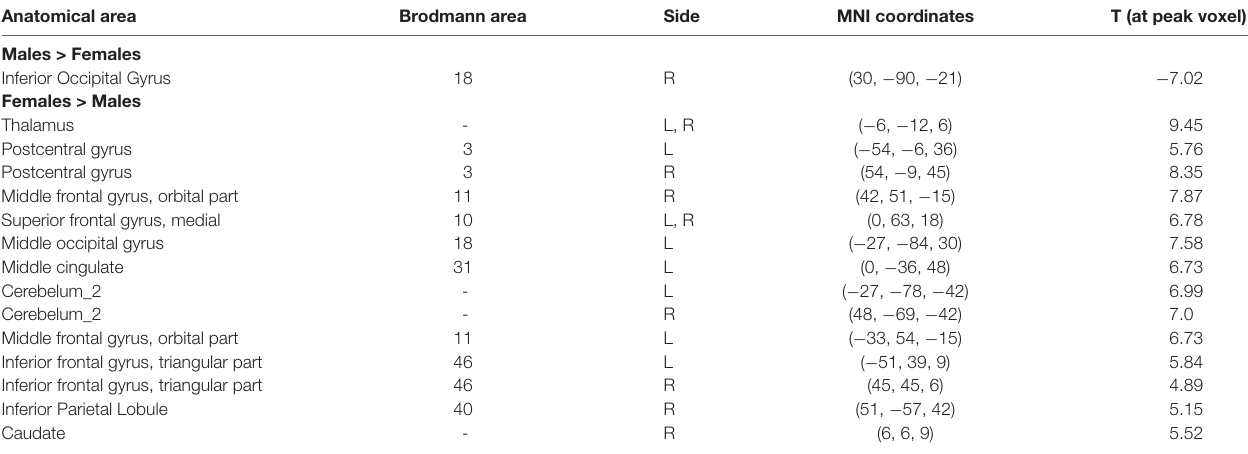
TABLE 1 | Brain areas showing gender differences in gray matter volume detected by univariate two-sample t -tests ( P < 0.05, FWE corrected). Anatomical area Brodmann area Side MNI coordinates T (at peak voxel) Males > Females Inferior Occipital Gyrus Females > Males Thalamus